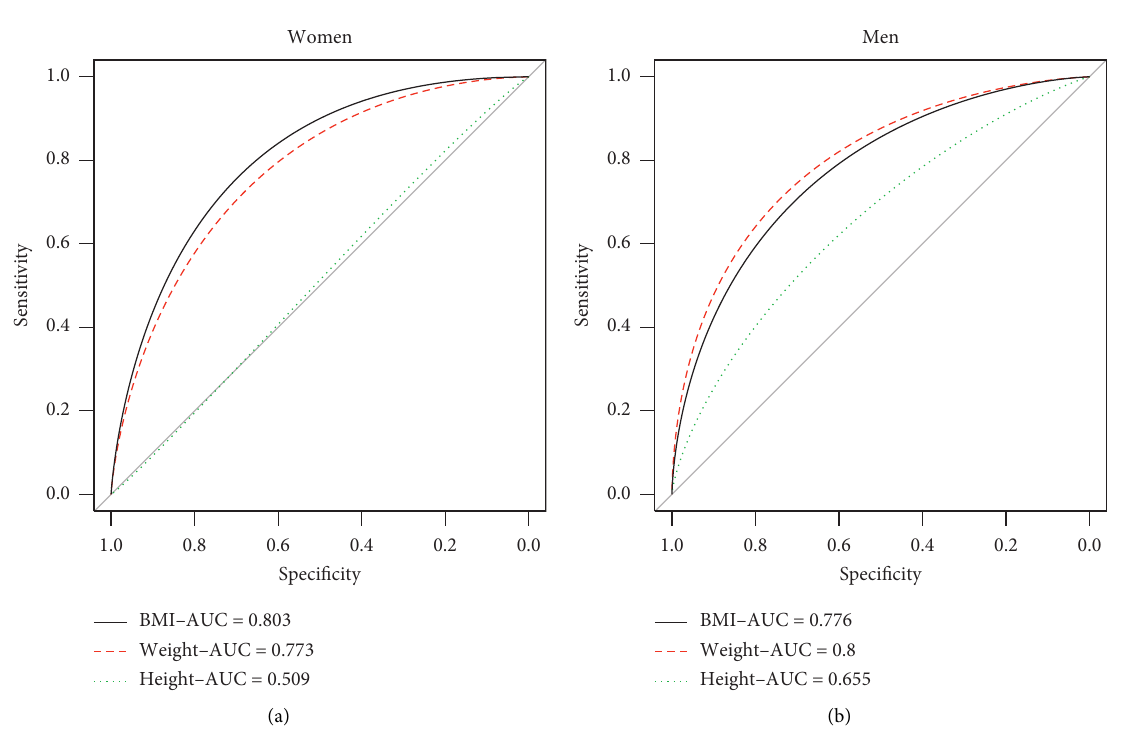
Figure 2: ROC curve of BMI (solid line), weight (dashed line), and height (dotted line). Left panel: female; right panel: male. AUC: area under the curve.